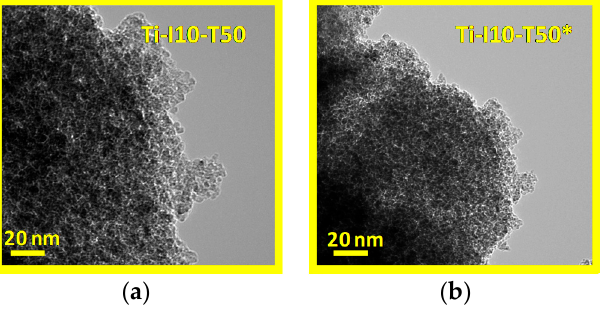
Figure 5. TEM images for the Ti-I10-TS50 ( a ) and Ti-I10-TS50* ( b ) samples.